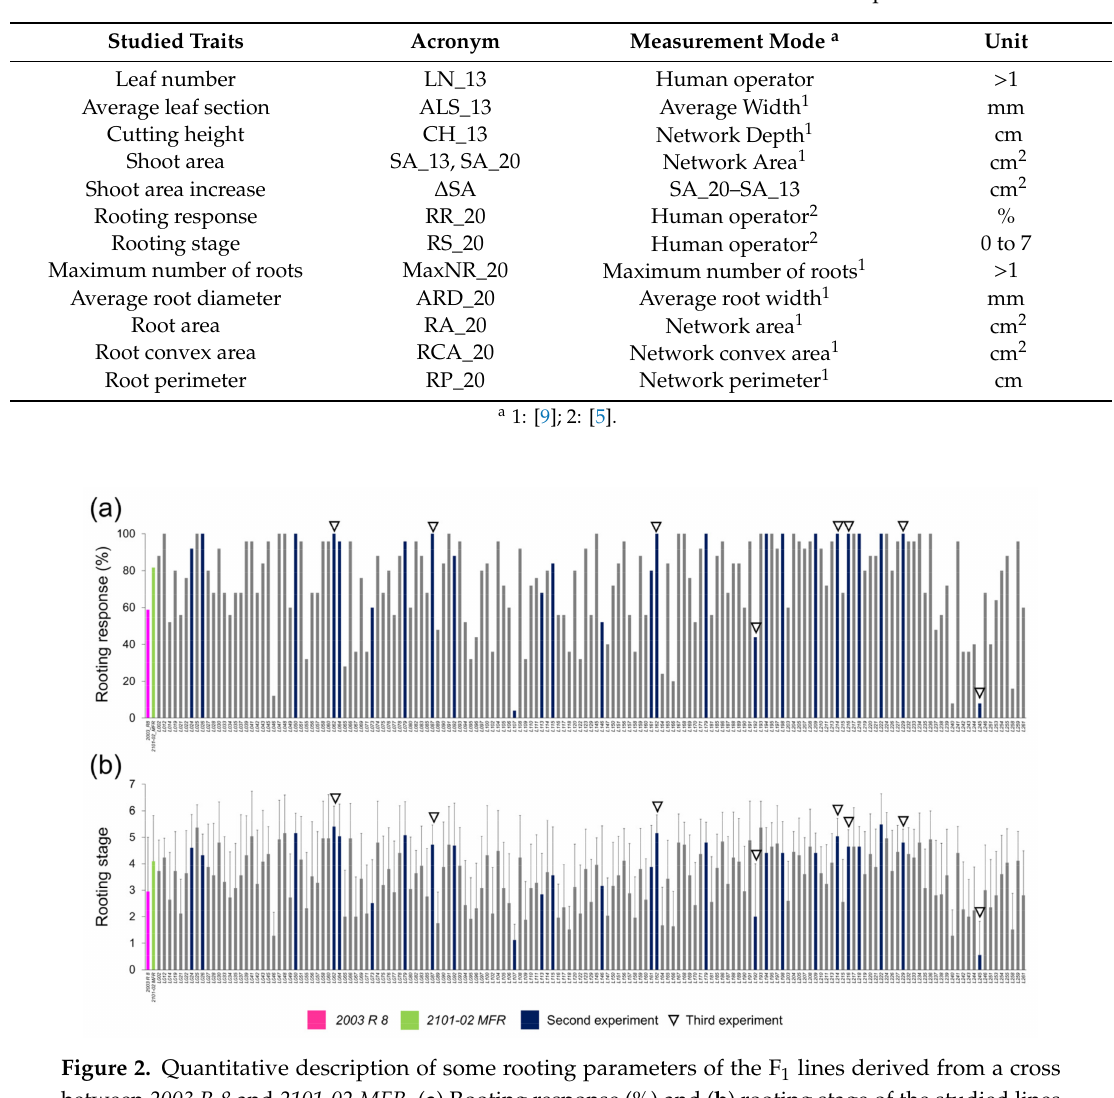
Table 1. Selected shoot and root traits measured in the first and second experiments.